Question: Summarize what this figure shows in one sentence.
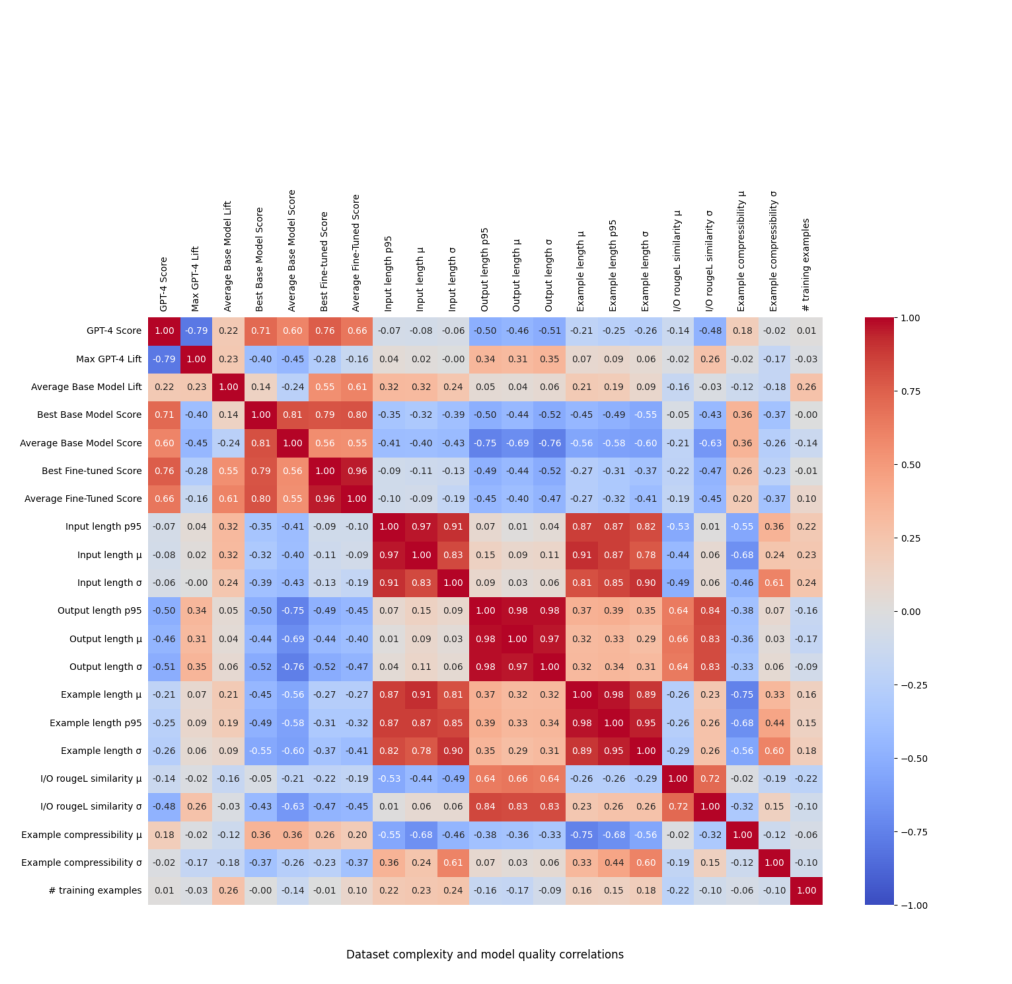
Answer: Correlations between dataset complexity and model quality correlations for 310 LLMs across 31 tasks, before and after LoRA-based fine-tuning.